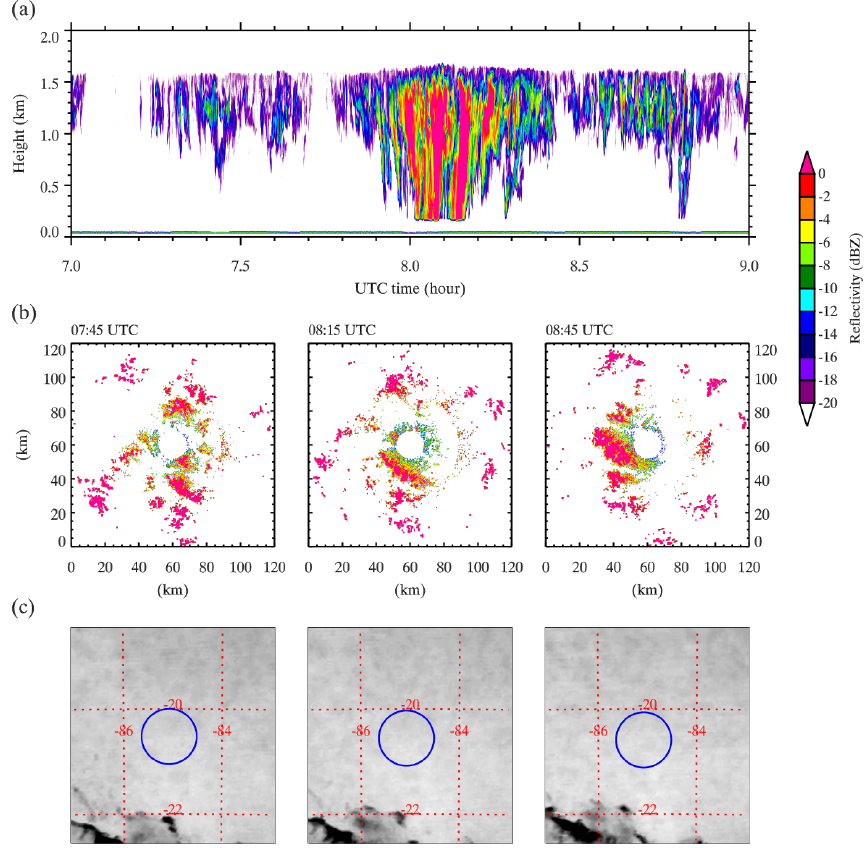
Figure 1. Ship- and satellite-based observations from VOCALS-REx between 07:00 and 09:00UTC on 23 November 2008: (a) W-band radar reflectivity, (b) C-band radar reflectivity and (c) corresponding GOES infrared image (4km resolution). The blue circle on each GOES image is the approximate range of the C-band